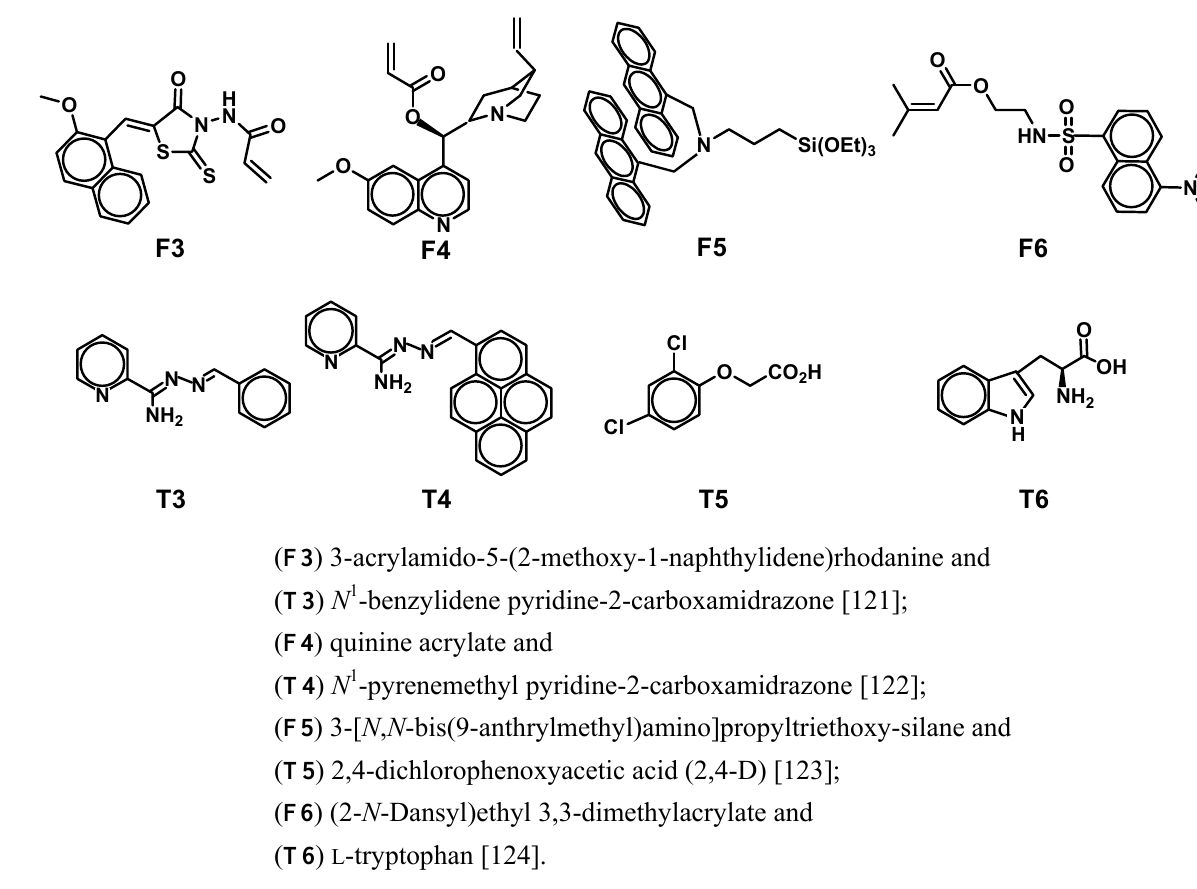
Figure 8. Fluorescent monomers ( F ) and the corresponding target analytes ( T